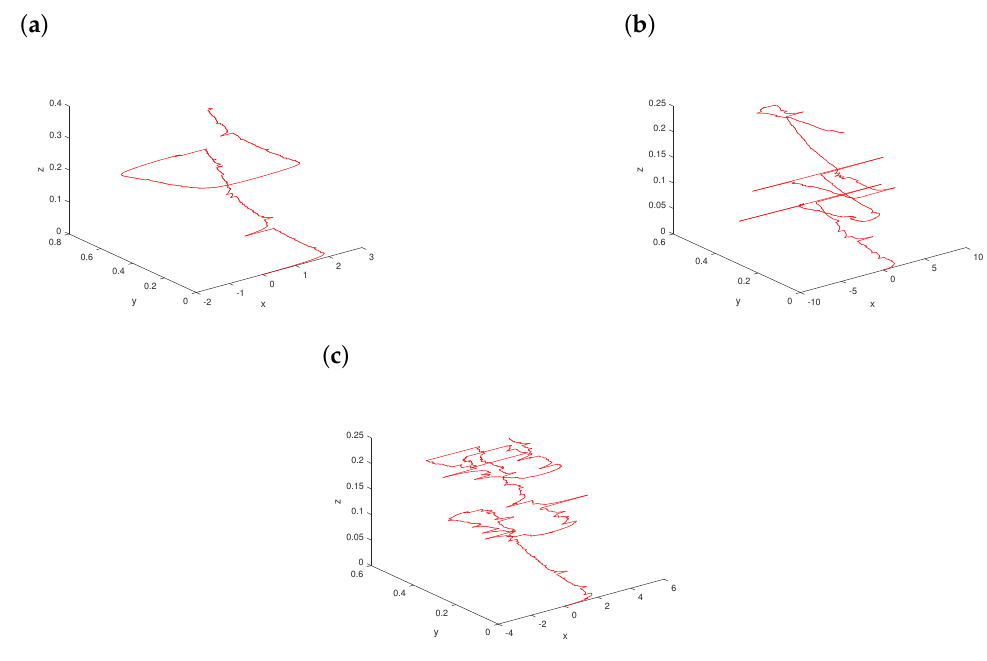
Figure 3. The evolution of system (7) starting from x ( 0 ) = y ( 0 ) = z ( 0 ) = 0 with a fixed stability index α = 1 and a scaling parameter (cid:101) = 0.05 as the noise intensity increases: ( a ) σ = 0.1; ( b ) σ = 0.5; ( c ) σ =